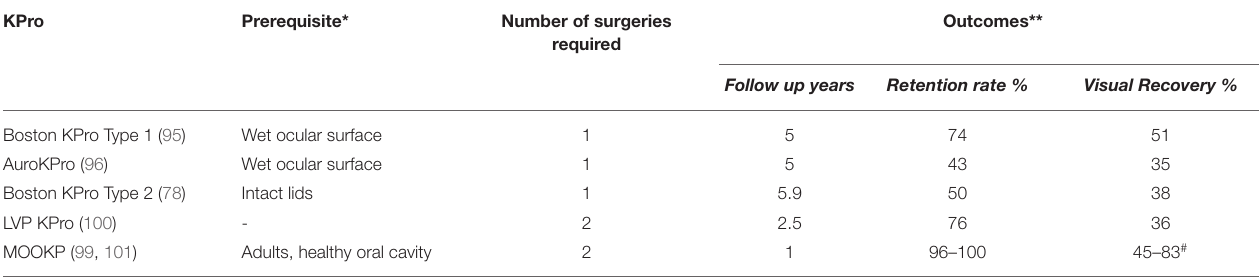
TABLE 3 | Comparison of the most commonly used keratoprosthesis in the management of limbal stem cell deficiency.